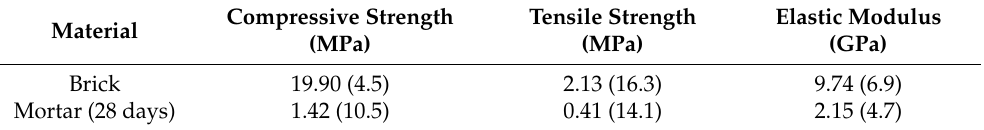
Table 1. Mechanical characterization of the constituent materials (CoV between parenthesis).